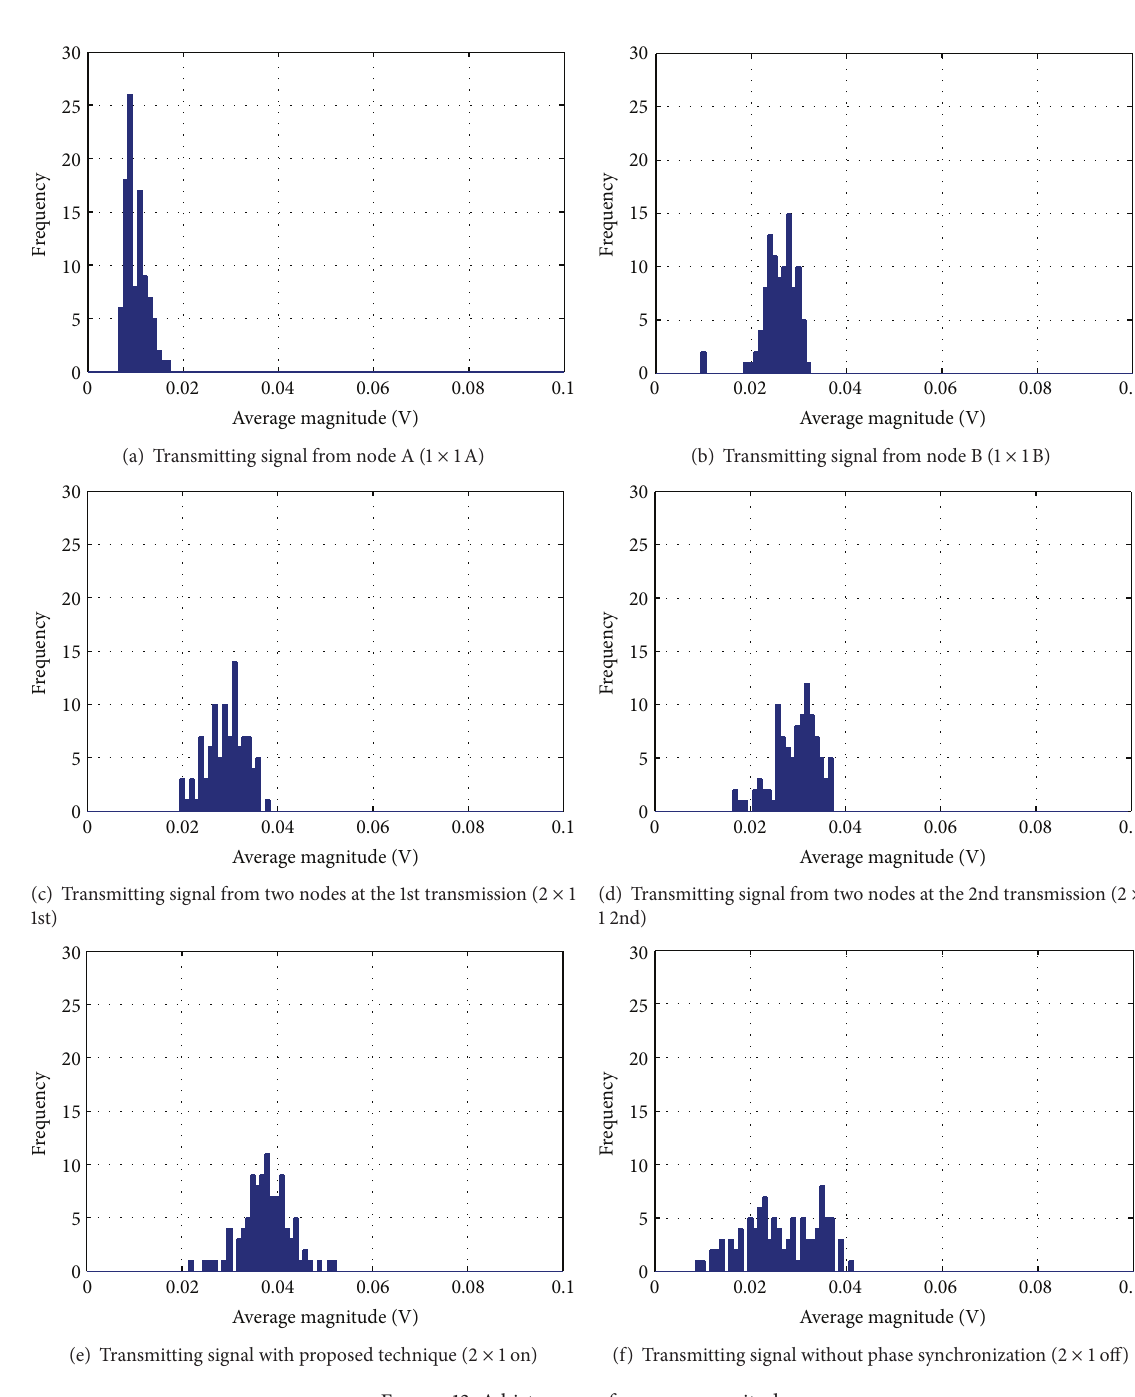
Figure 13: A histogram of average